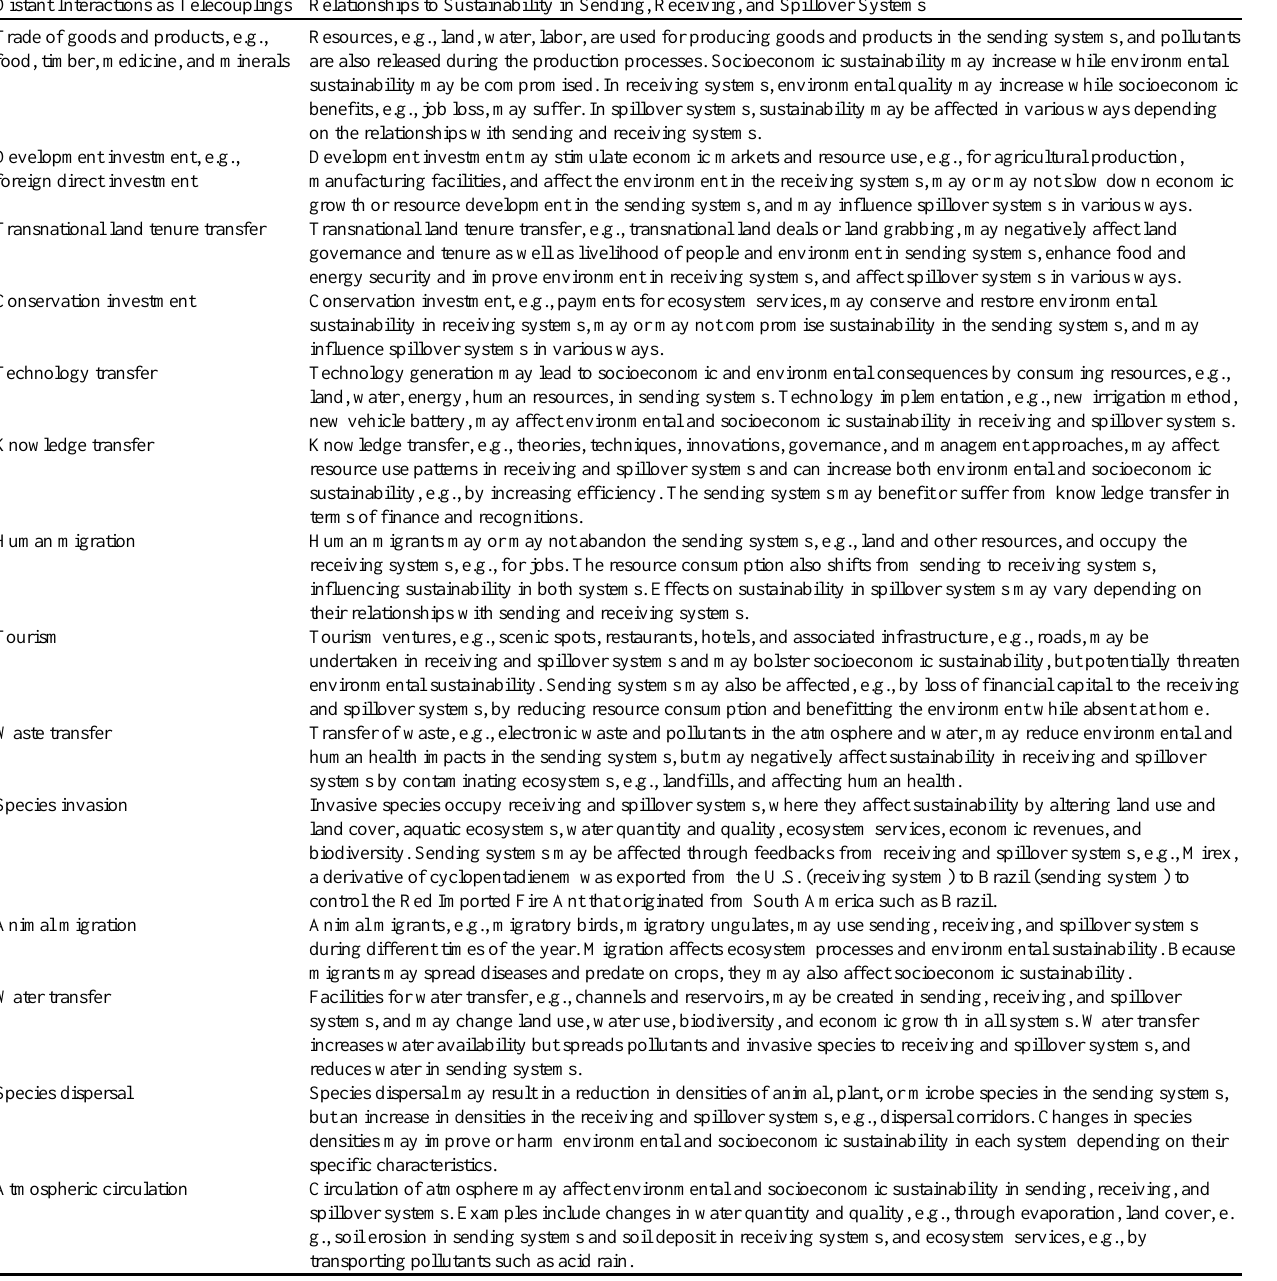
Table 2 . More examples of distant interactions as telecouplings and actual/hypothetical relationships to sustainability in sending, receiving, and spillover systems. Only some attributes of telecouplings have been studied in the past and most attributes remain unknown. Feedbacks among different systems are not stated for the sake of simplicity. Distant Interactions as Telecouplings Relationships to Sustainability in Sending, Receiving, and Spillover